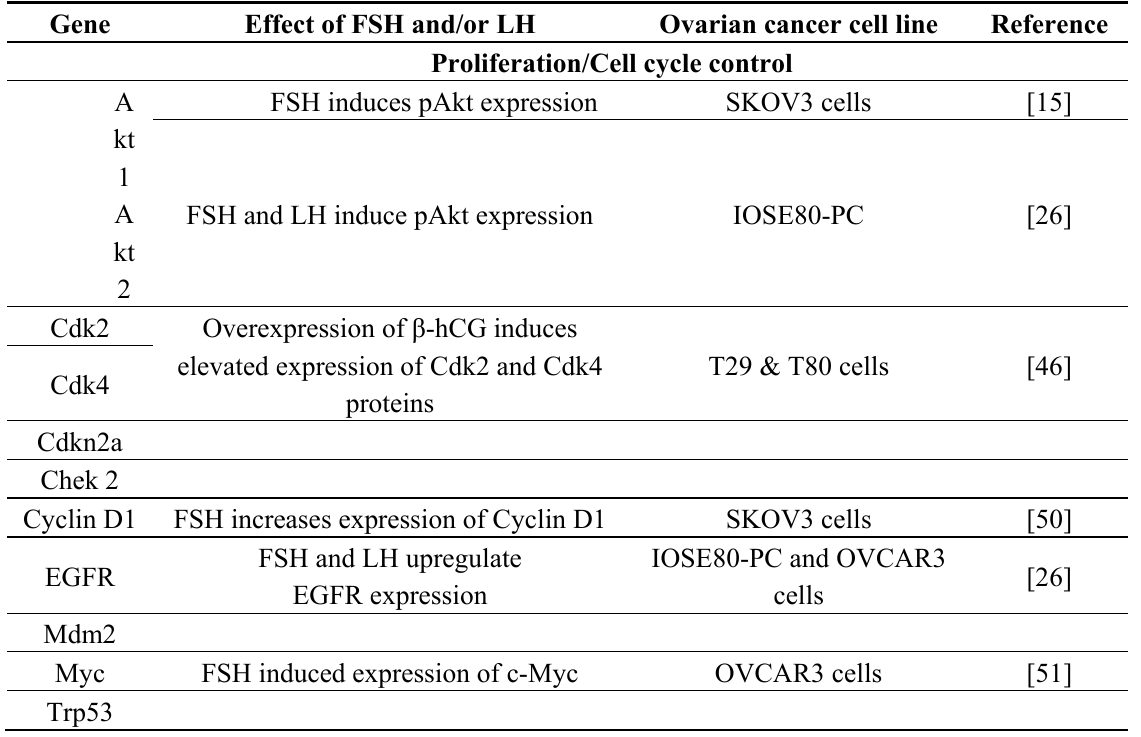
Table S1. Modified version of table 1. List of publications corresponding to gonadotropin-induced upregulation of specific genes listed in the table.